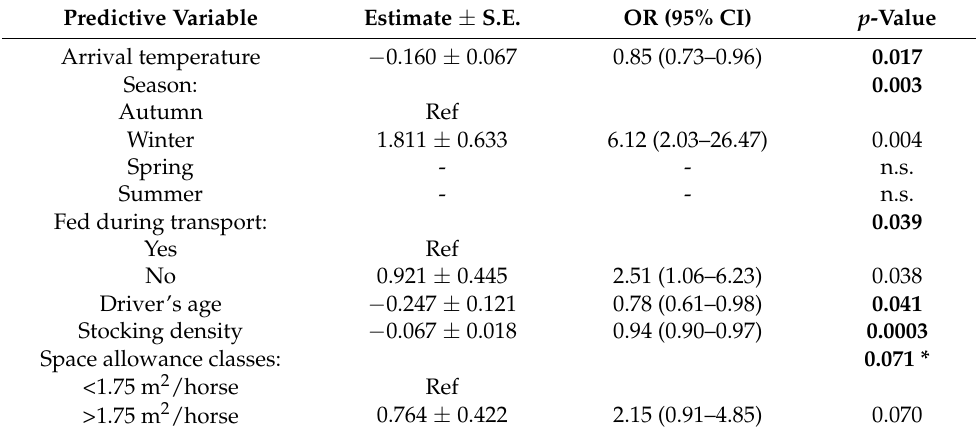
Table 12. Significant associations between the predictive variables and the presence/absence of diarrhea and abnormal feces at 24 h after unloading. Data are presented as estimate, standard error (S.E.), odds ratio (OR), confidence interval (95% CI), and p -value. Predictive Variable